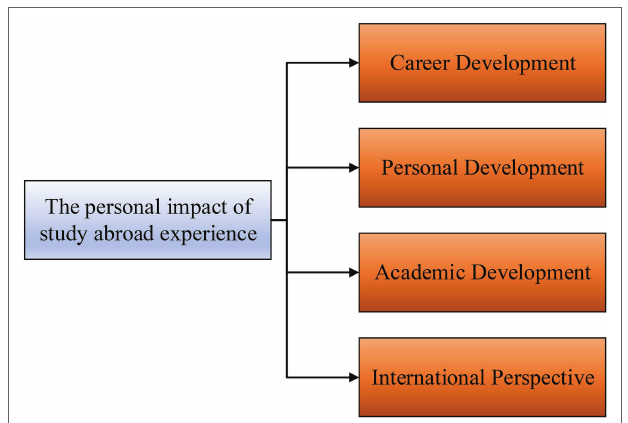
FIGURE 1 | Impact of study abroad experience on overseas Chinese returnees.